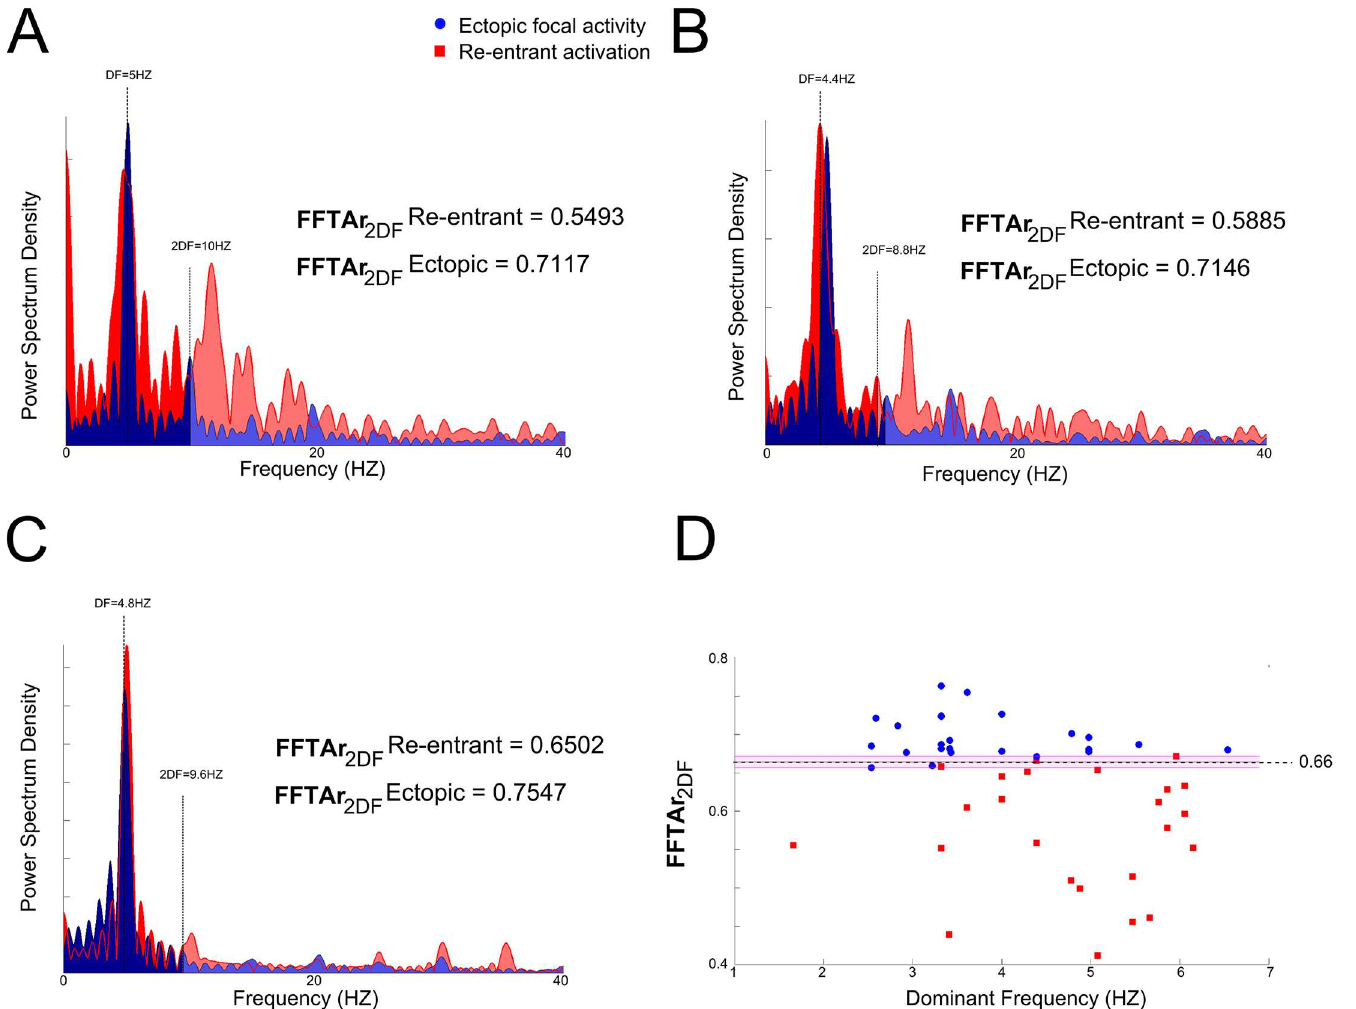
Fig 5. Normalized power spectral density for ectopic focal and re-entrant activation. Normalizedpower spectral density for ectopic focal (blue) and re- entrant (red) activity locatedin (A) SAN; (B) PV and (C) RAA. The darker shadowcorresponds to the area between 0–2 x DF. (D): a scatter plot of (AFFTr 2DF ) againstthe DF, the magentaarea is the overlappingarea where both activities can occur. AFFTr 2DF is the ratio of the area under the power spectrum density in the ranges 0 –(2 x DF) Hz and (2 x DF)– 50 Hz: AFFTr 2DF = Area 0-2DF /Area